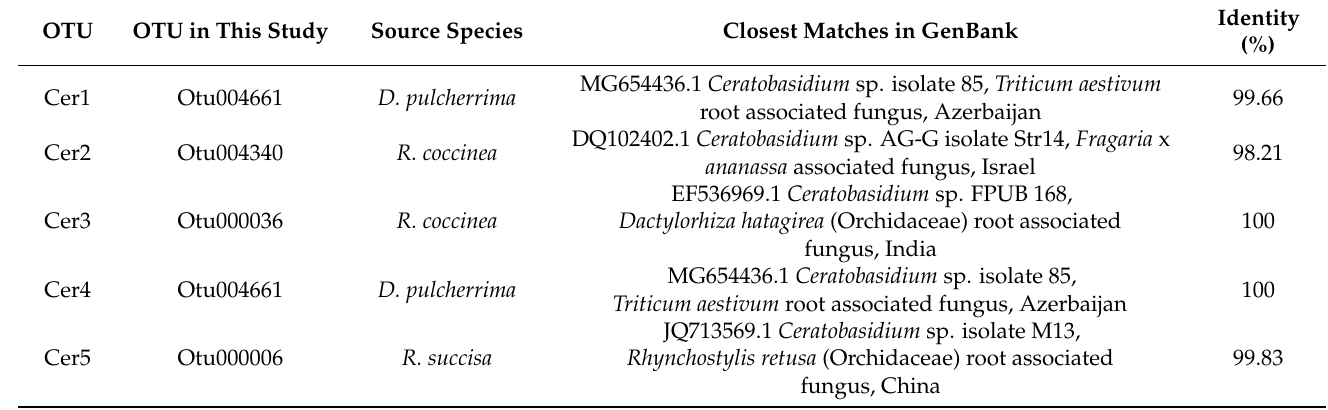
Table 3. Operational taxonomic units (OTUs) of fungi isolated from the four orchids and their possible identities. Internal transcribed spacer (ITS) sequencing was performed, and sequences were annotated to assess the fungi present in the root samples of four orchid